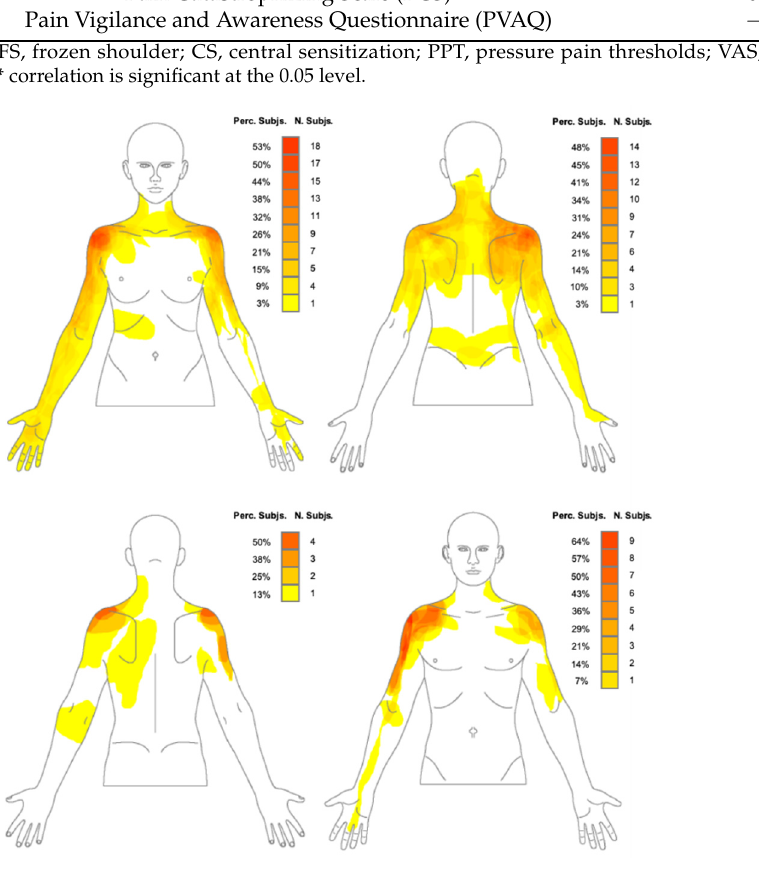
Figure 1. Pain frequency and pain location maps in men and women with frozen shoulder. The color grid indicates both the number and the percentage of participants reporting pain in that specific area. Dark red represents the most frequently reported painful area.